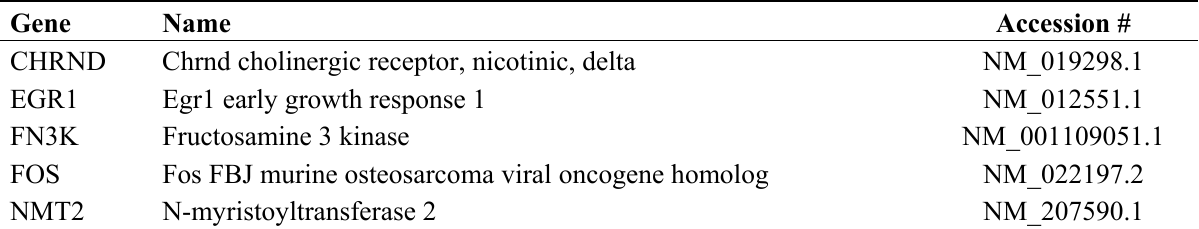
Table 6. Validated genes found to be associated with genotoxic